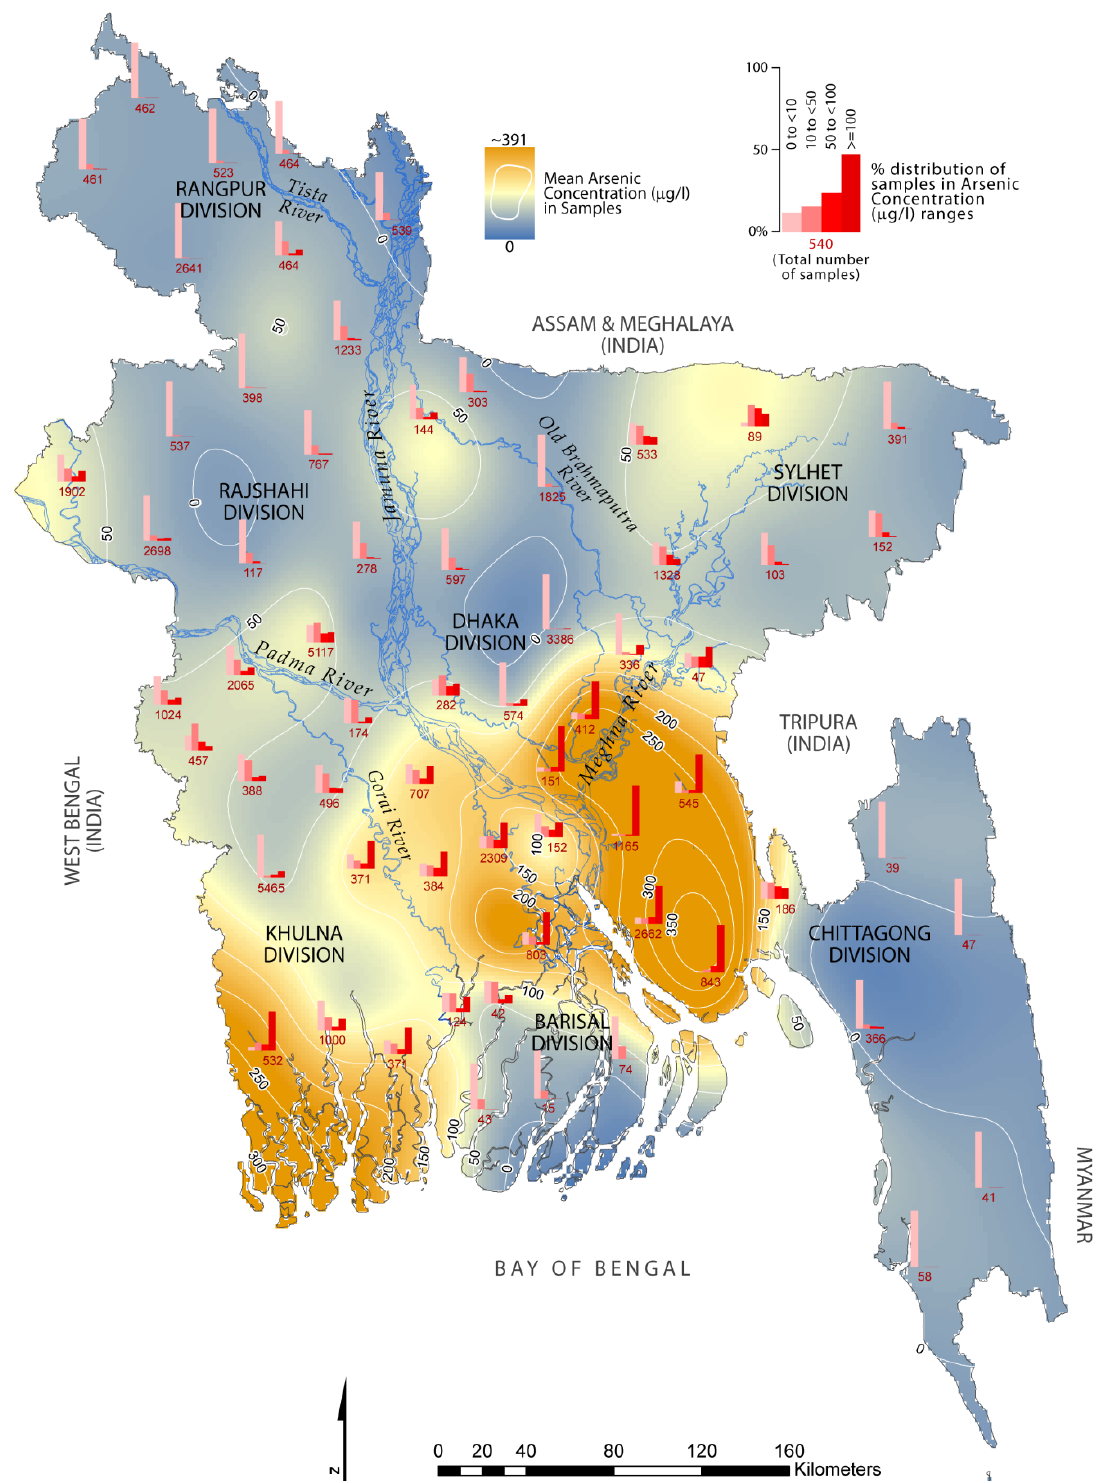
Figure 1. Arsenic (As) concentrations in groundwater of Bangladesh, showing all 64 districts under seven administrative divisions. N = 52,202 tubewells samples; where n = 6,787, 11,814, 12,169, 1,101, 5,999, 13,597 and 735 were representative samples of Rangpur, Rajshahi, Khulna, Barisal, Chittagong, Dhaka and Sylhet divisions, respectively (data source: